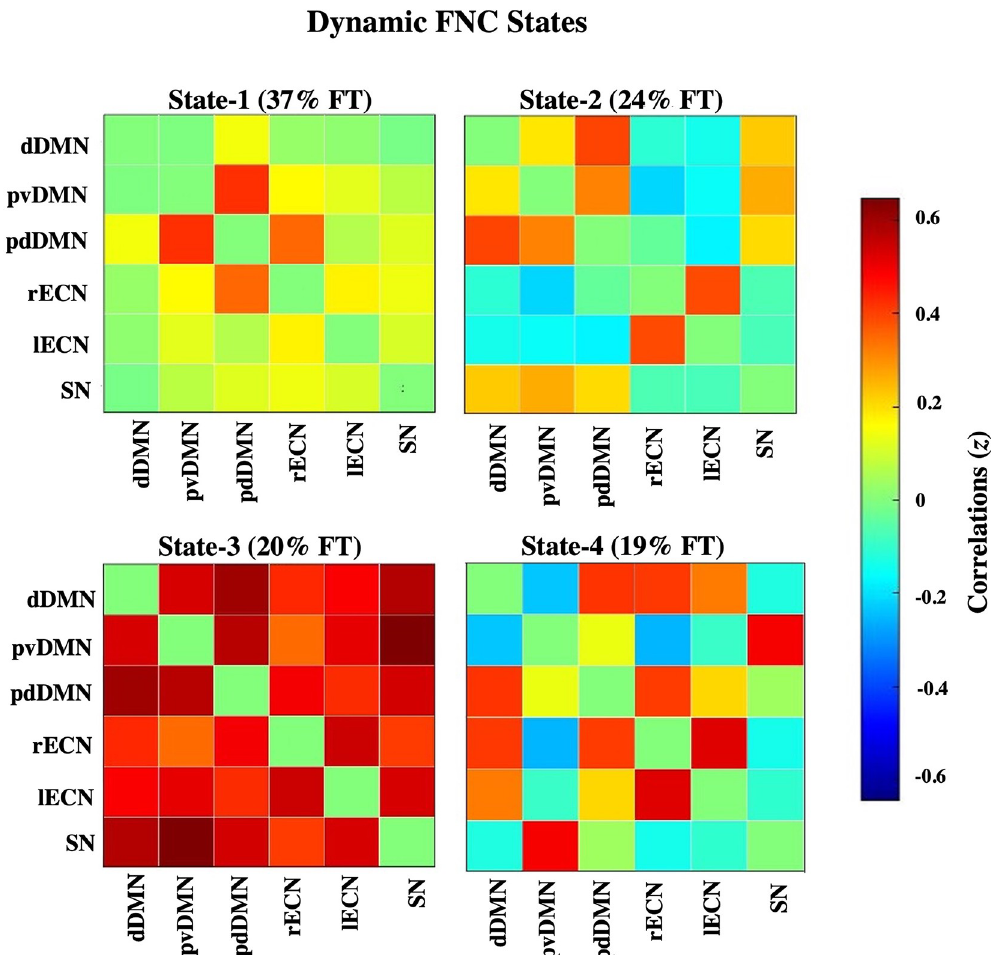
Fig 2. Dynamic FNC results. Correlation matrices showing the fraction time and pattern of cross-network functional connectivity (represented using z-scores) of each of the four dynamic FNC states. 74 participants entered State-1, 66 participants entered State-2, 54 participants entered State-3, and 50 participants entered State-4. dDMN = dorsal default mode network; pvDMN = posterior ventral default mode network; pdDMN = posterior dorsal default mode network; rECN = right executive control network; lECN = left executive control network; SN = salience network.